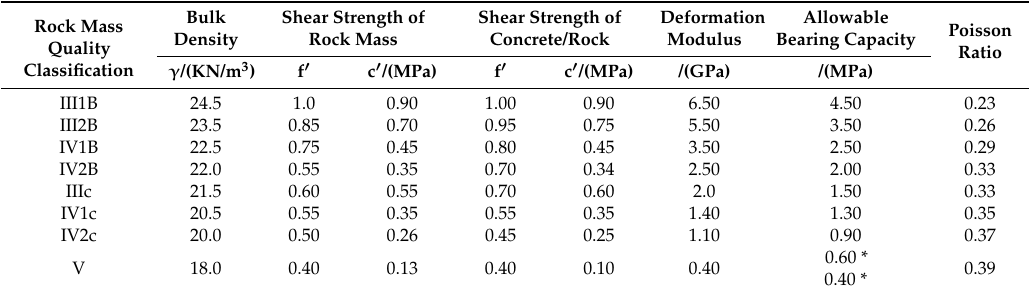
Table 2. Mechanical parameters of different rock mass classification regarding capulin San Pablo dam.